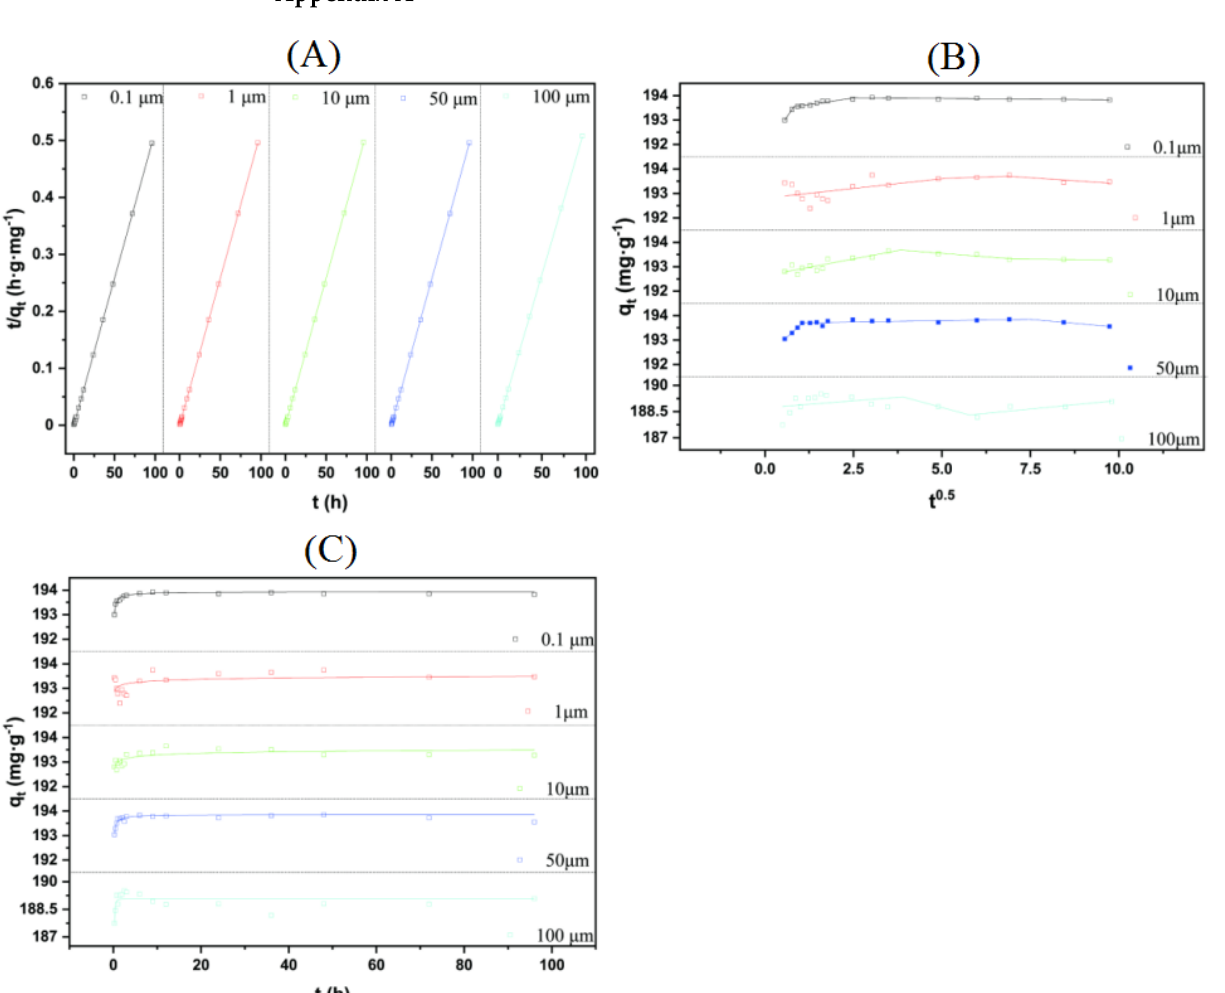
Figure A1. The plots of adsorption kinetics fitted by pseudo-second-order kinetic ( A ), intra − particle diffusion kinetics ( B ) and Bangham modes ( C ). The adsorption of NP (4 mg/L) and PS − MPs (20 µ g/mL) of different particle sizes were studied.